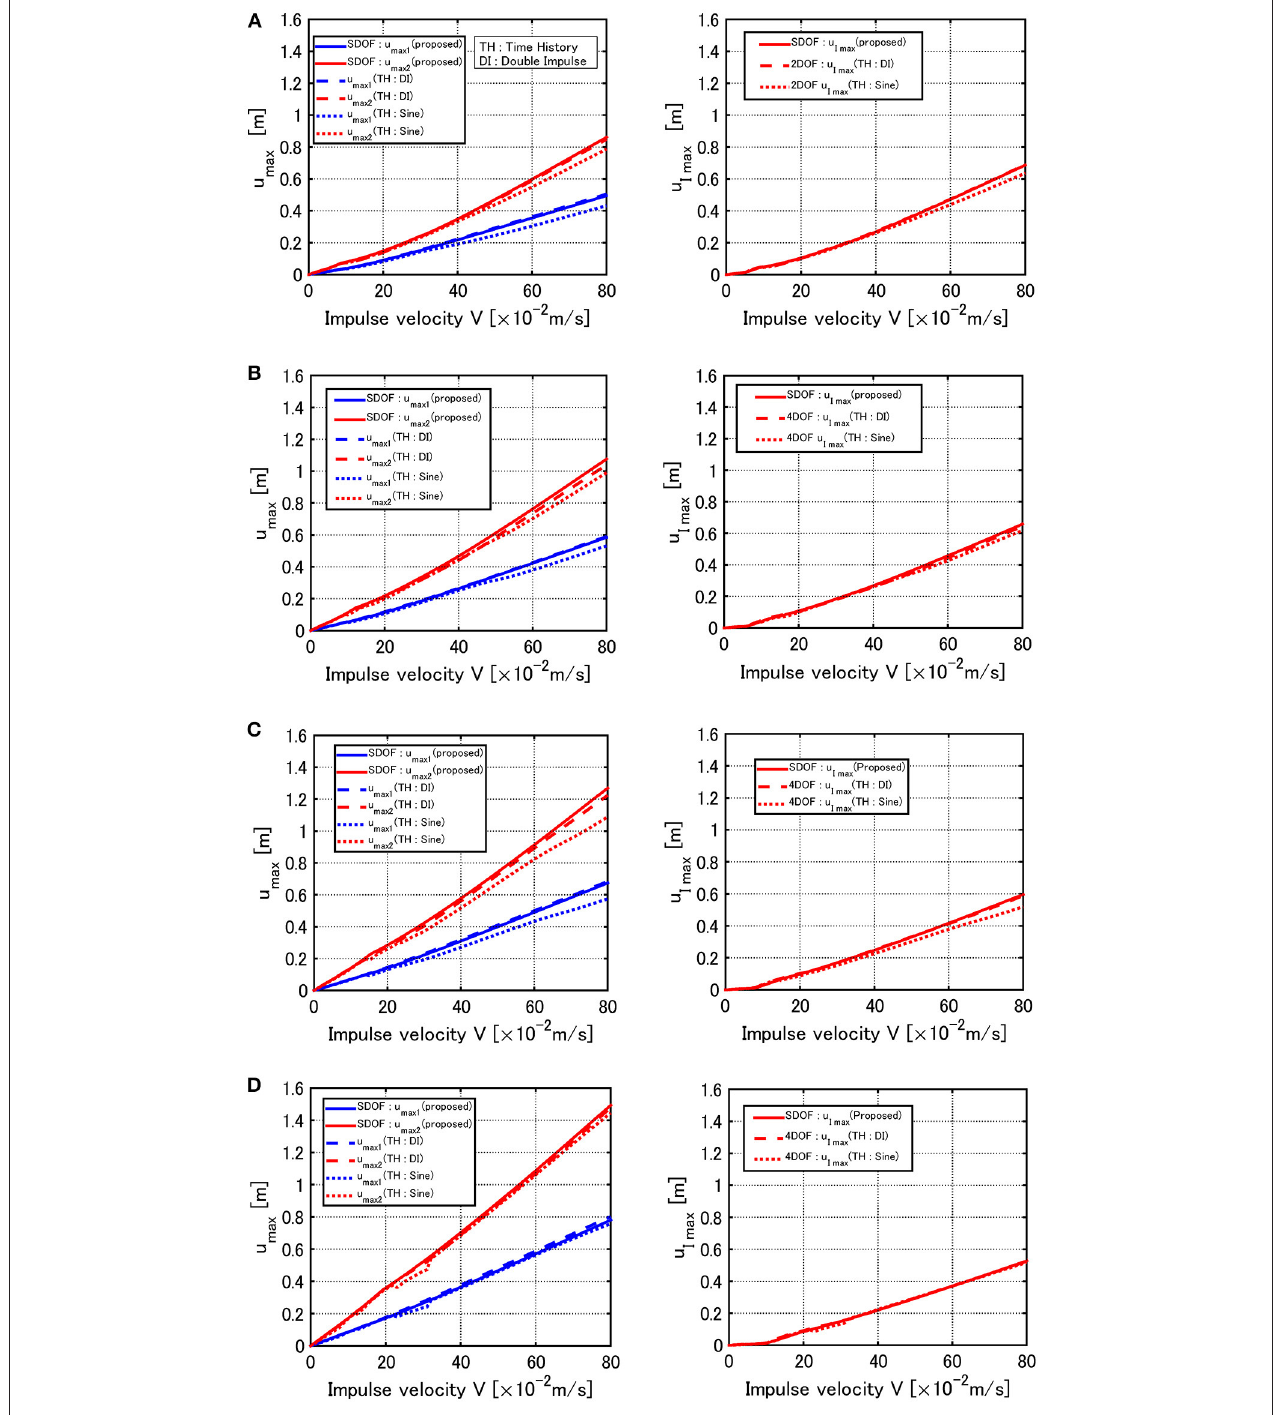
FIGURE 11 | Comparison of maximum deformations of 20-story model for the proposed method, time-history response analysis under double impulse and time-history response analysis under corresponding one-cycle sine wave, (A) Rigid ground, (B) Soil type 1, (C) Soil type 2, (D) Soil type 3.